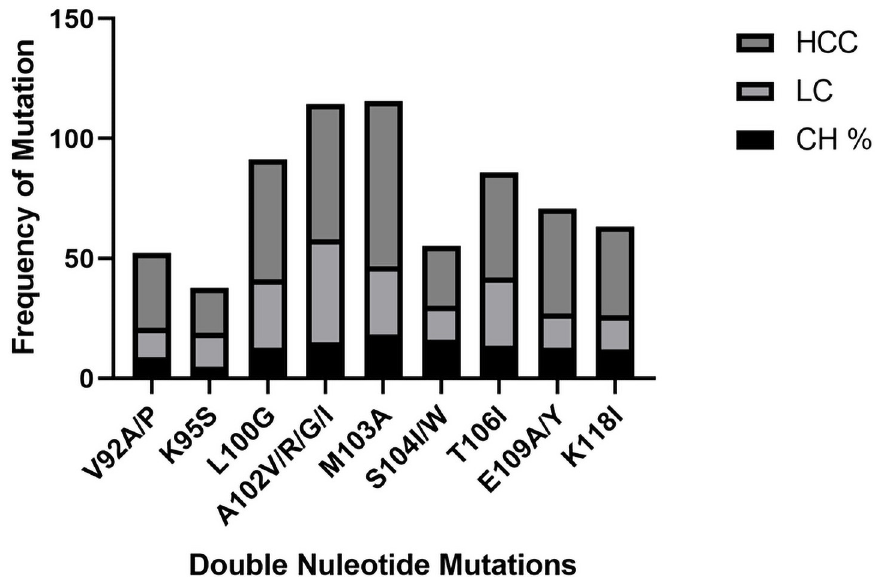
Fig 7. Frequency of double nucleotide mutations in CH, LC, and HCC